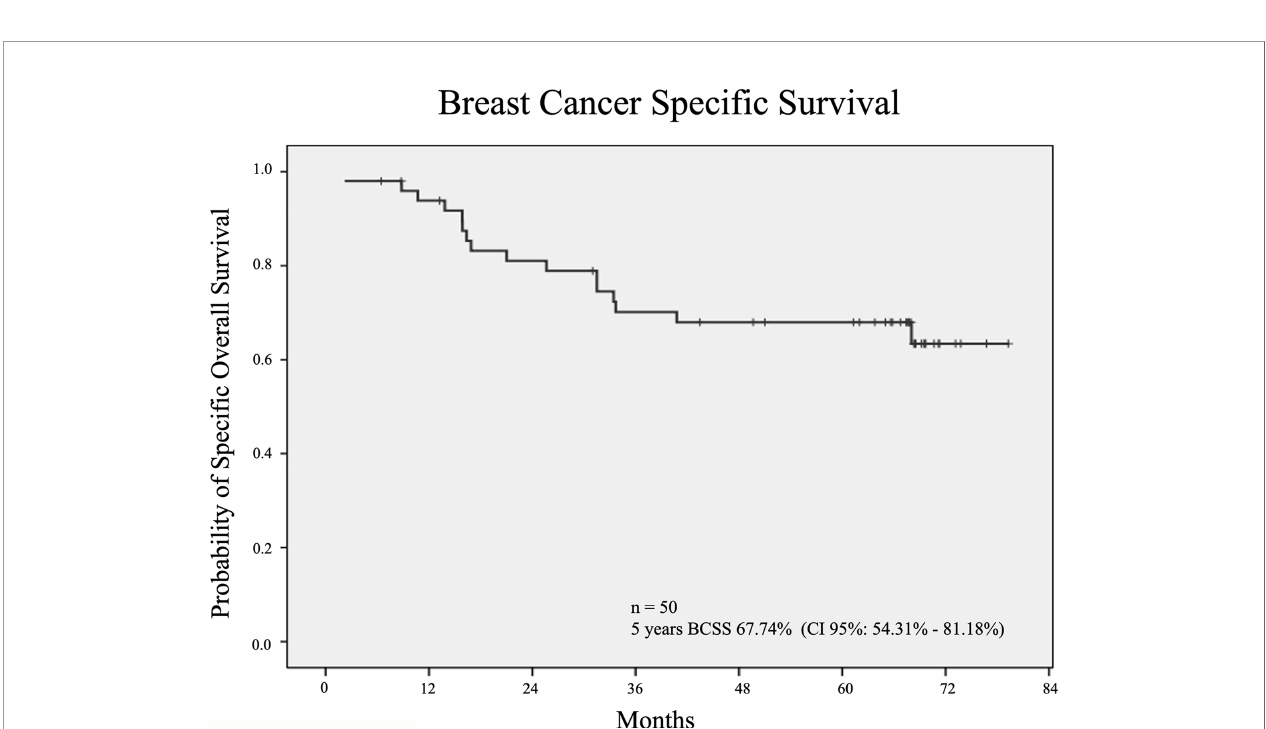
FIGURE 5 | Kaplan Meier curves for BCSS. n, number; BCSS, Breast Cancer Speci fi c Survival; CI, Con fi dence Interval.